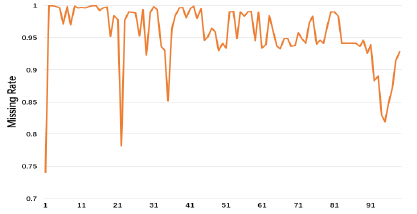
Figure 7. Missing rate of 99 variables in MIMIC-III. x -axis, missing rate, y -axis, variable id in MIMIC-III. maximum missing rate: 0.9997, minimum missing rate: 0.7406, average missing rate: